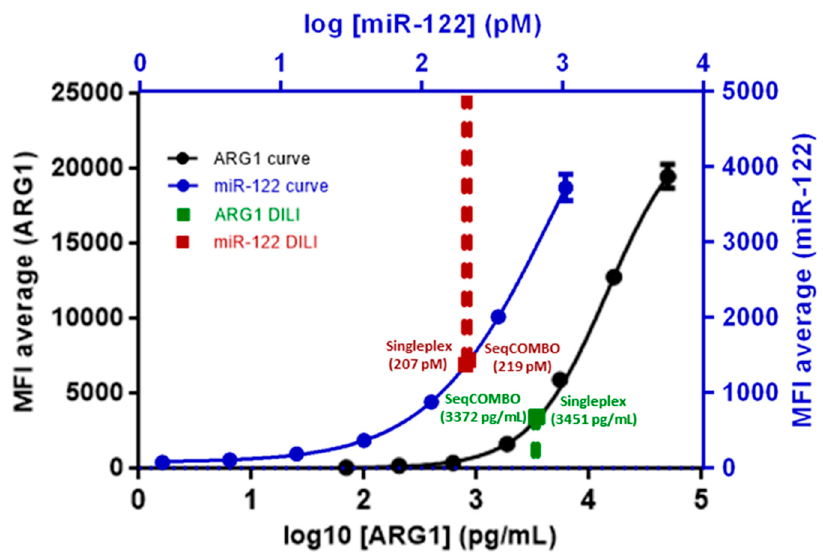
Figure 2. ARG1 and miR-122 calibration curves with interpolated ARG1 and miR-122 from DILI samples. Error bars ( ± 1 s.d.) based on triplicate measurements. The error bars are smaller than the size of some data points. n = 3.